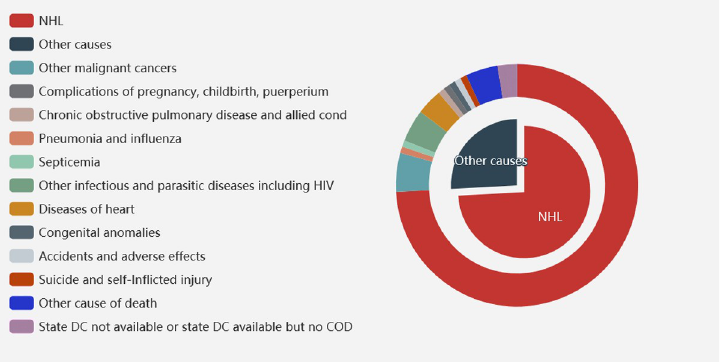
Fig 2. Distribution of causes of death of follow-up in patients with extra nodal natural killer/T-cell lymphoma, nasal type, 1987–2014.